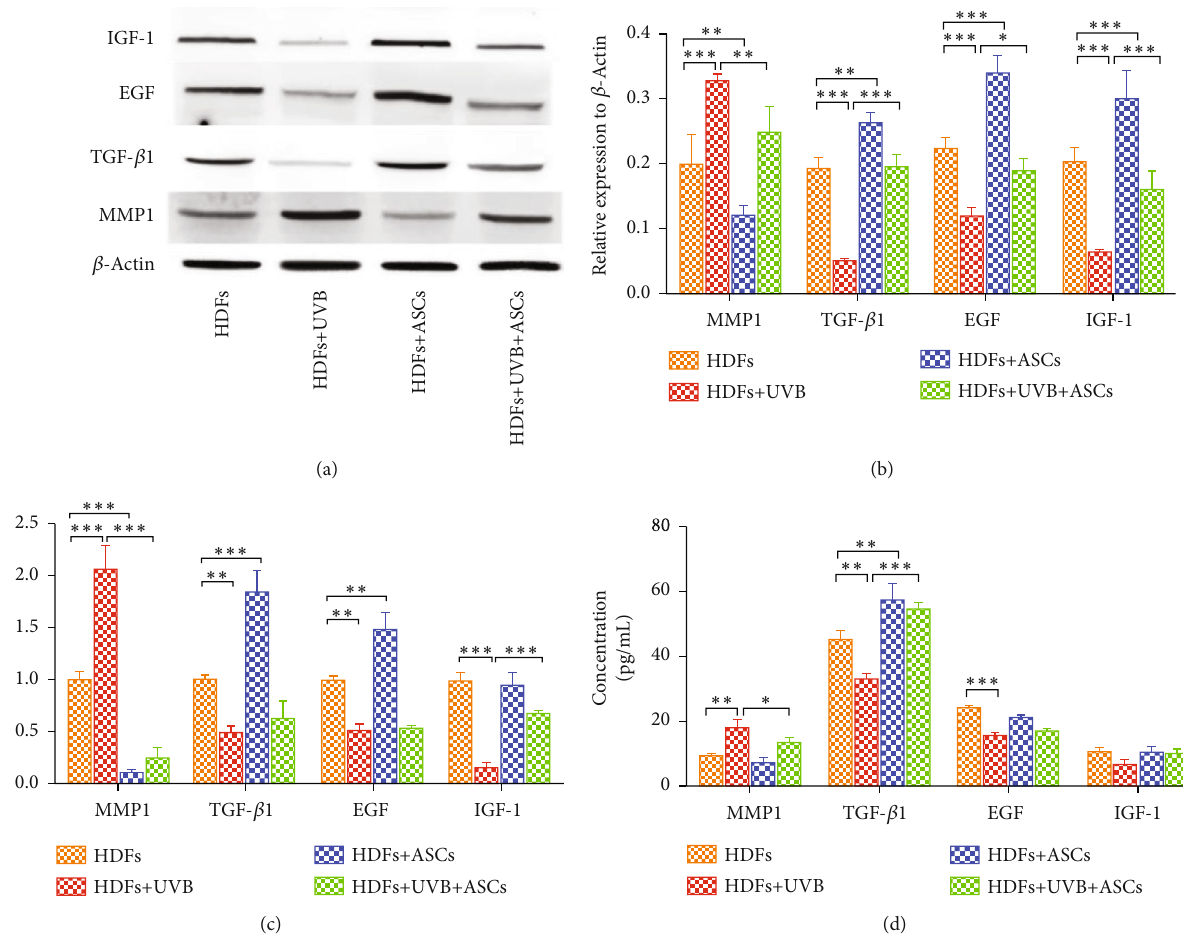
Figure 5: Cytokine expression involved in ECM remodeling and skin aging. (a) Western blots showing cytokine expression in HDFs. (b) Western blots quantitative analysis of cytokine expression. (c) RT-PCR showing the gene expression of cytokines in HDFs. (d) The expression of cytokines in the cell culture